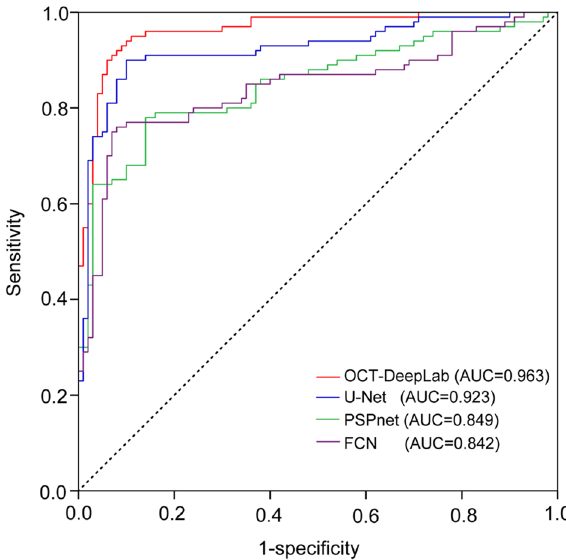
Figure 10. ROC curves from the segmentation of macular edema by different